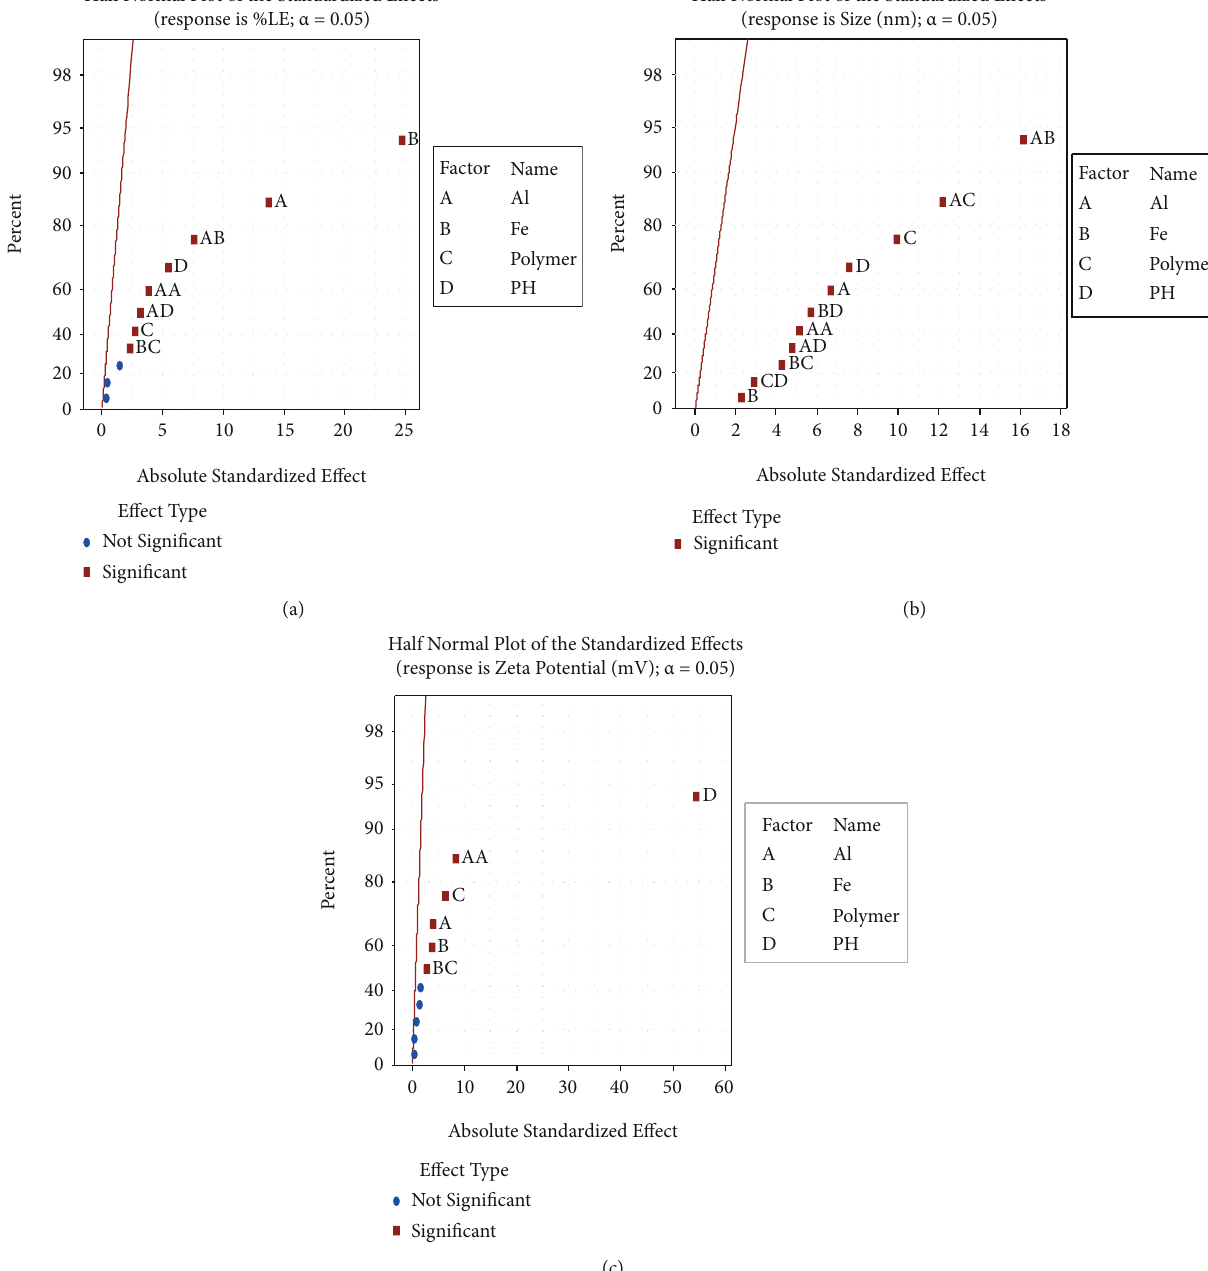
Figure 2: (a) Half normal plot of the standardized e ff ects for %LE, (b) particle size, and (c) zeta